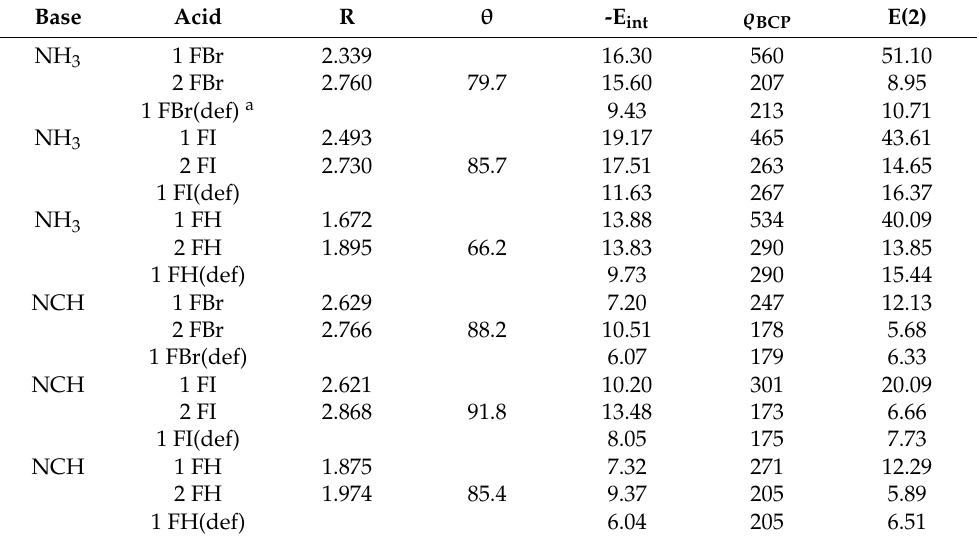
Table 1. Intermolecular distances (R, Å), interaction energies (kcal/mol), bond critical point density ( (cid:36) BCP , 10 − 4 au), and NBO N lp → σ *(FX) perturbation energy E(2) (kcal/mol) for complexes where one or two Lewis acids share a single lone pair on the N-base, and θ (X ·· N ·· X) angle (degs) for bifurcated bonds.